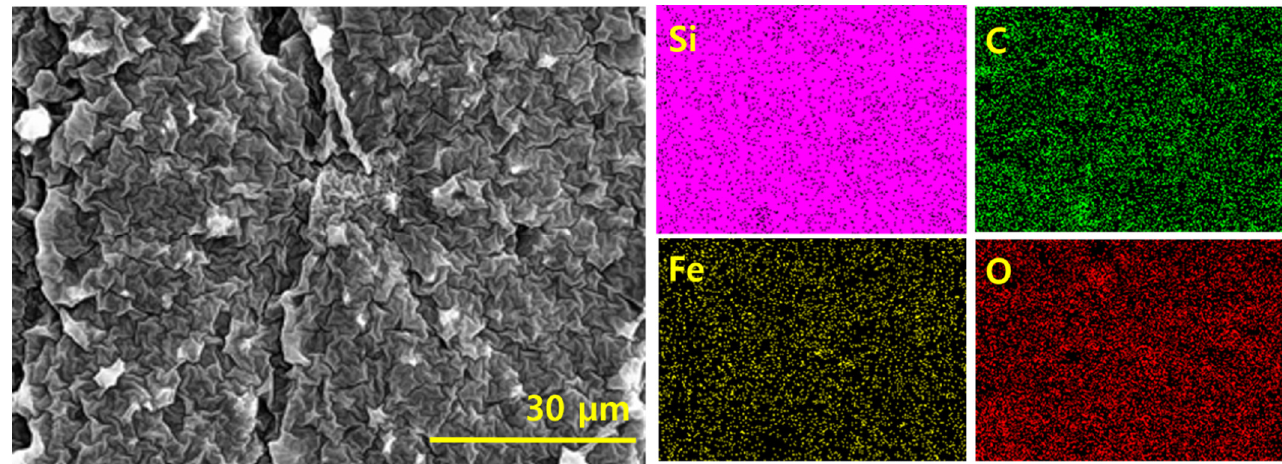
Figure 4. SEM and element maps of different elements in hybrid